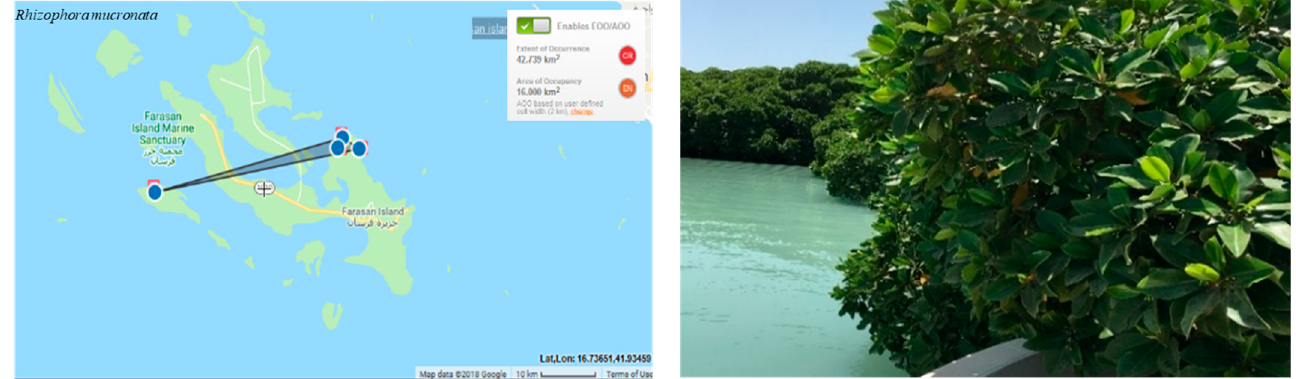
Figure 4. Geographical distribution of Rhizophora mucronate in the Farasan Archipelago (plant photo by R. Al-Qthanin from Faranan Alkabir